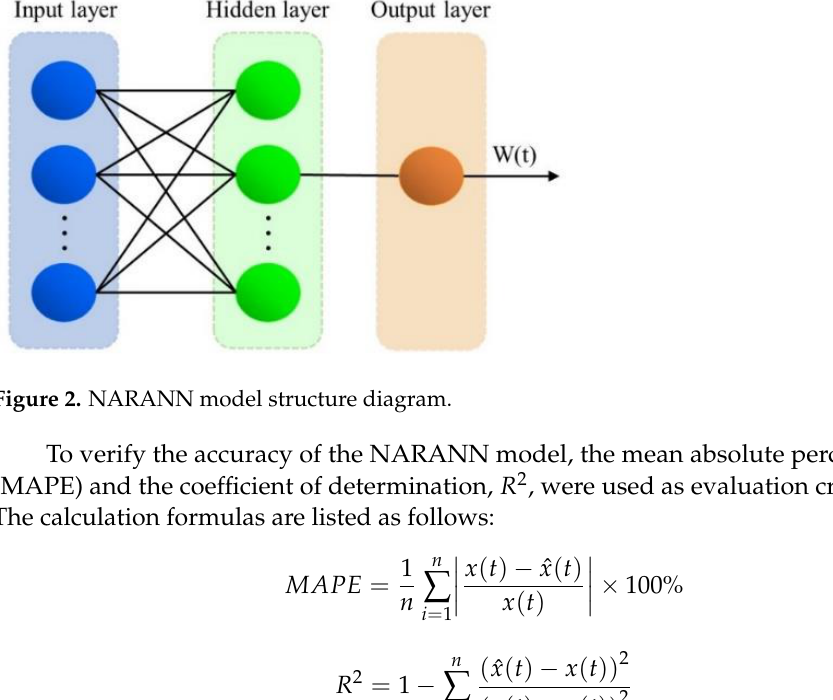
Table 1. Parameters for construction waste generation estimates.